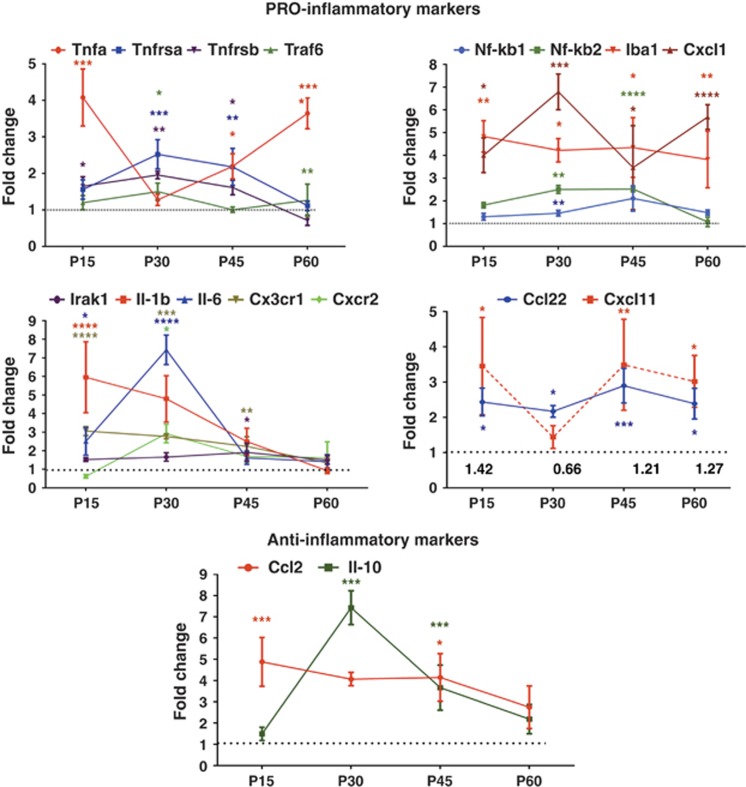
ADRP progression in T17M RHO mice was accompanied by activation of
the inflammatory response as measured by qRT-PCR (N=4). Pro-
and anti-inflammatory markers were detected in P15, 30, 45 and 60 ADRP
retinas. The distribution of data values is shown in S.E.M.,
*P<0.05, **P<0.01,
***P<0.001 and
****P<0. 0001